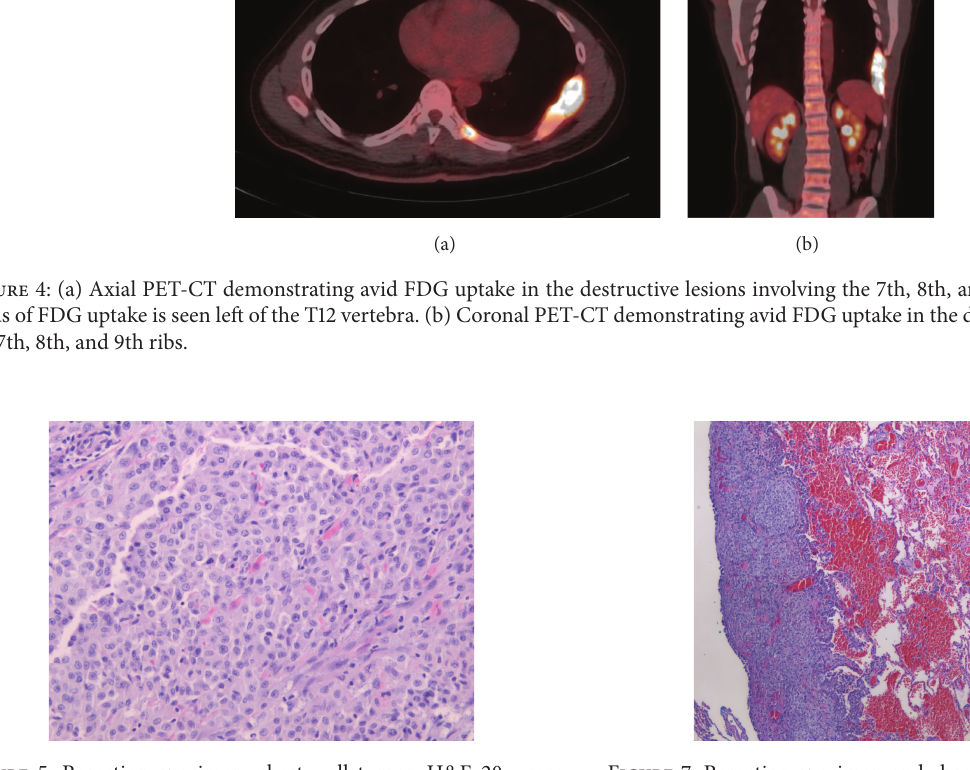
Figure 5: Resection specimen, chest wall tumor, H&E 20x: rare epithelioid foci present in the 10cm mass and involving the lung parenchyma.